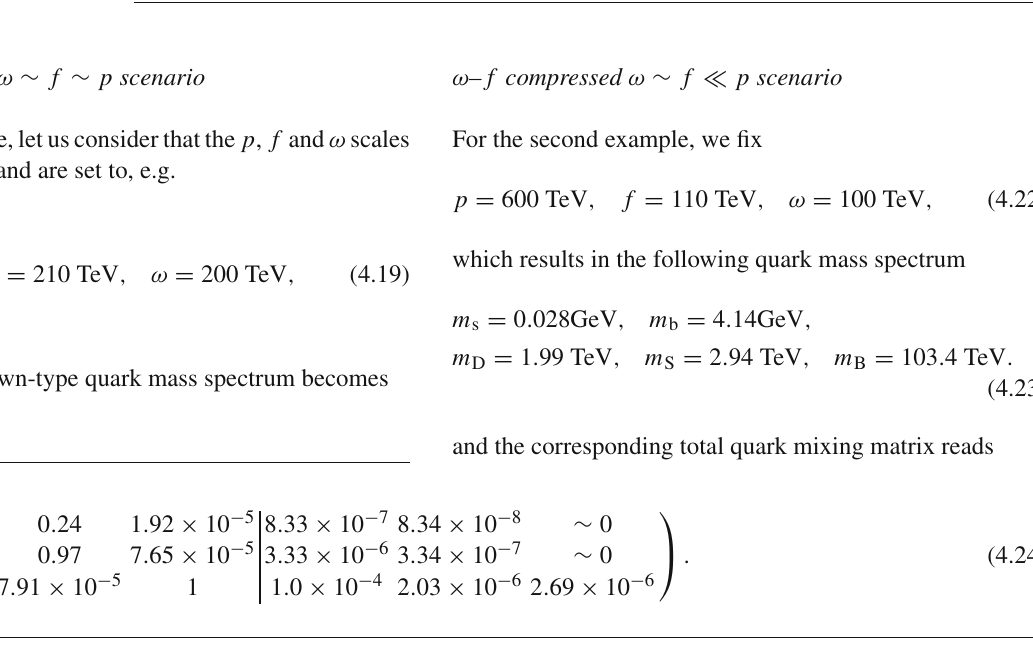
Table 6 An example for an order of magnitude estimation of VLQ mass scales relevant for numerical considerations in this